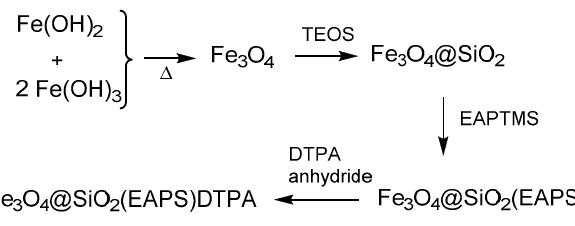
Figure 3. The final, engineered nanoparticles Fe 3 O 4 @SiO 2 /EAPS/DTPA will be simply referred to as NP@DTPA, except when their specific composition becomes relevant.